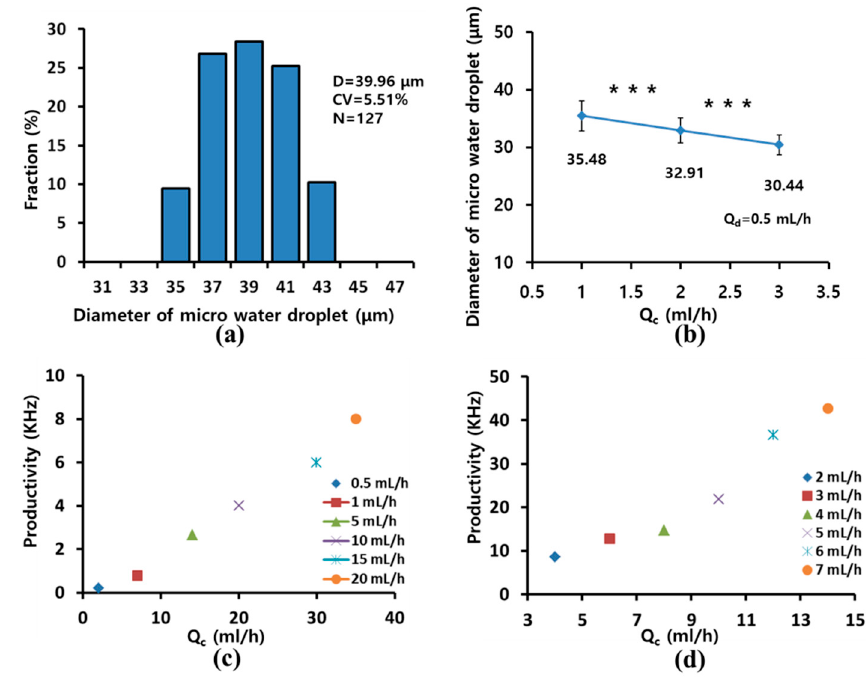
Figure 7. ( a ) Size distribution of water microdroplets produced by the 512-channel geometrical passive breakup device for Q d and Q c of 2 and 3 mL / h; ( b ) diameter of water microdroplets according to flow rate (*** p < 0.001); ( c ) productivity of microdroplets with 16-channel T-junction passive breakup; ( d ) productivity with 512-channel geometrical passive breakup device.